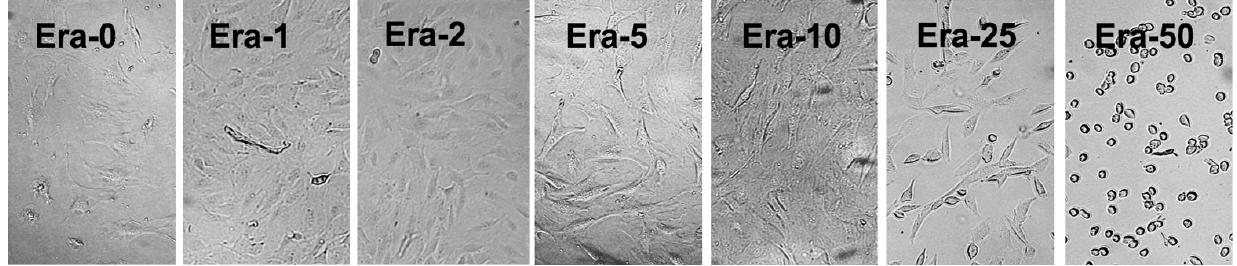
Figure 2. Optical microscope images of the effect of Era-0, 1, 2, 5, 10, 25, and 50 on the MC3T3-E1 cells after the 2 h incu- bation.